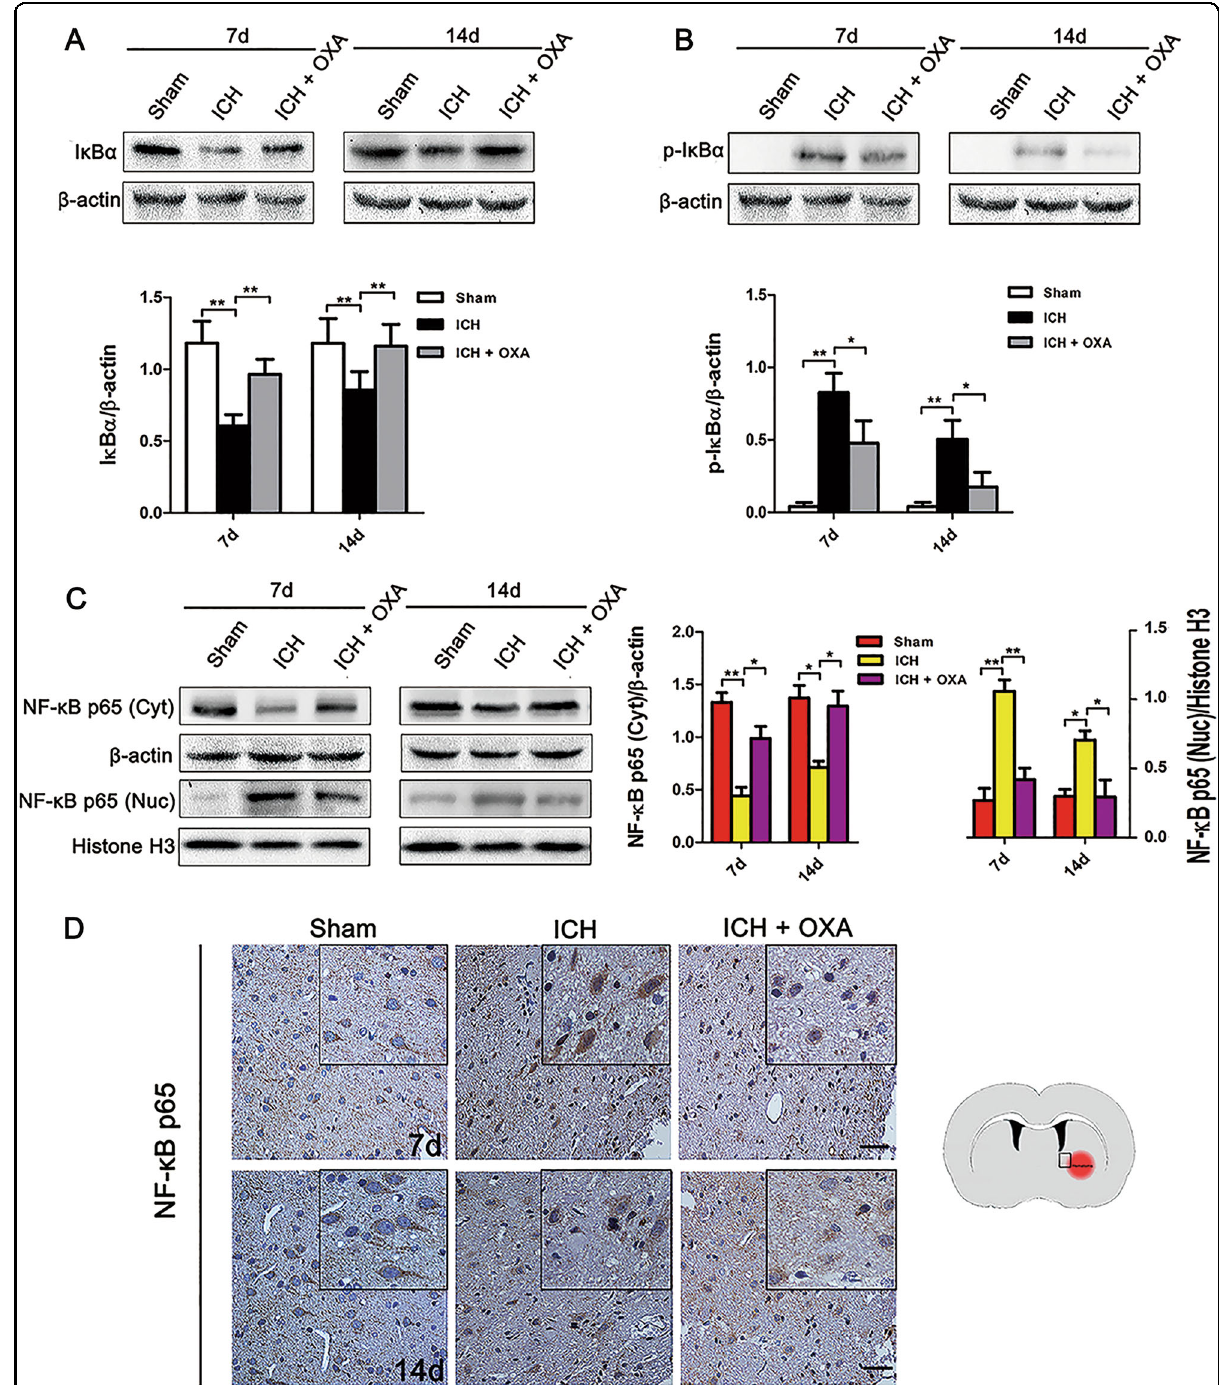
Fig. 3 a , b Degradation and phosphorylation of I κ B α occurred after ICH. OXA dramatically inhibited this effect. c Nuclear translocation of NF- κ B p65 was signi fi cantly increased after ICH. This effect was signi fi cantly blocked by OXA. d Immunohistochemical analysis showed that NF- κ B p65 was mainly retained in the cytoplasm in the Sham group, but some of the NF- κ B p65 was transferred into the nucleus after ICH. ICH intracerebral hemorrhage, OXA oxamate. * p < 0.05 and ** p < 0.01. n = 5. Scale bar = 50 μ